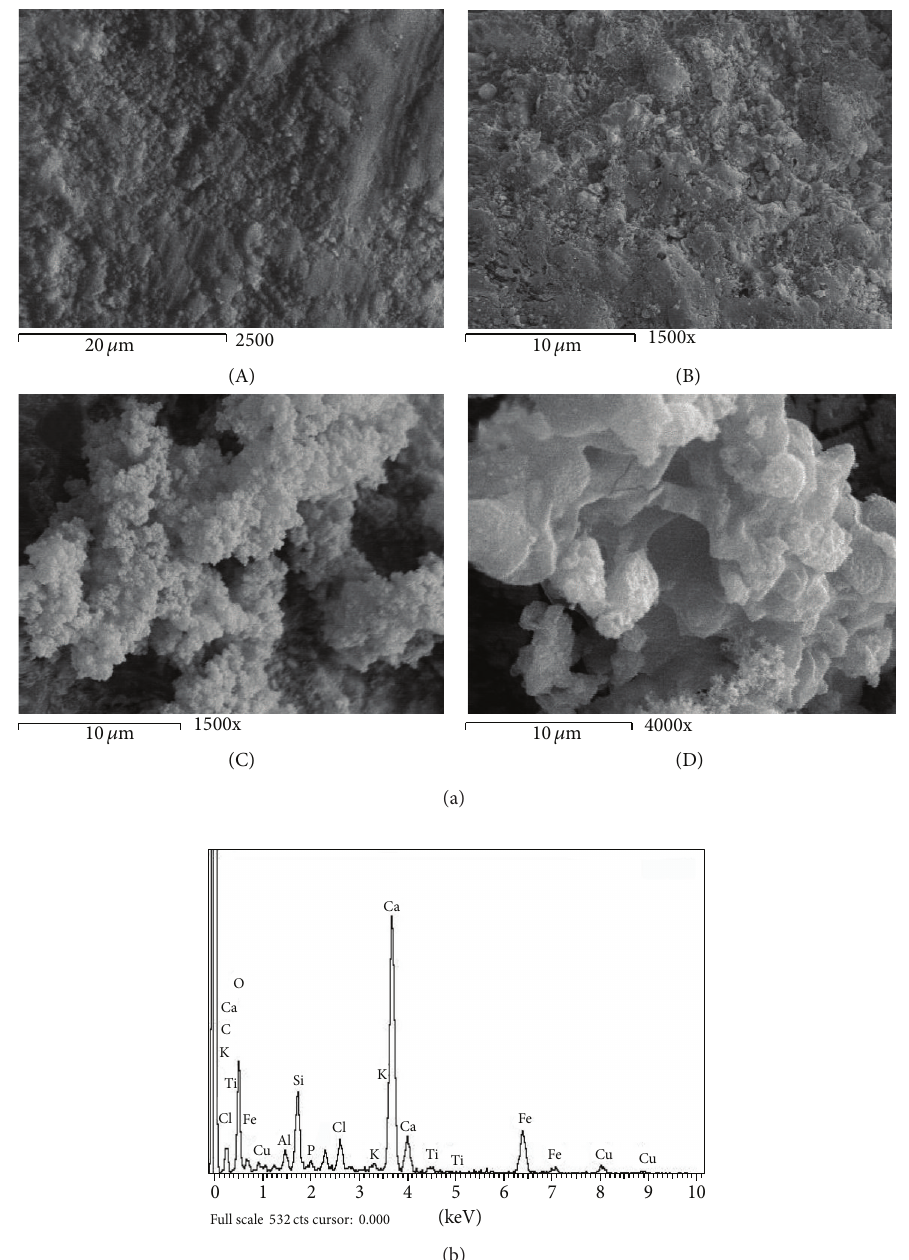
Figure 4: (a) SEM micrograph of Cu-doped glass ceramics (A) before, (B) after 1 week, (C) after 2 weeks, and (D) after 4 weeks of immersion in SBF. (b) EDAX of Cu-doped glass ceramics after 4-week immersion in SBF.